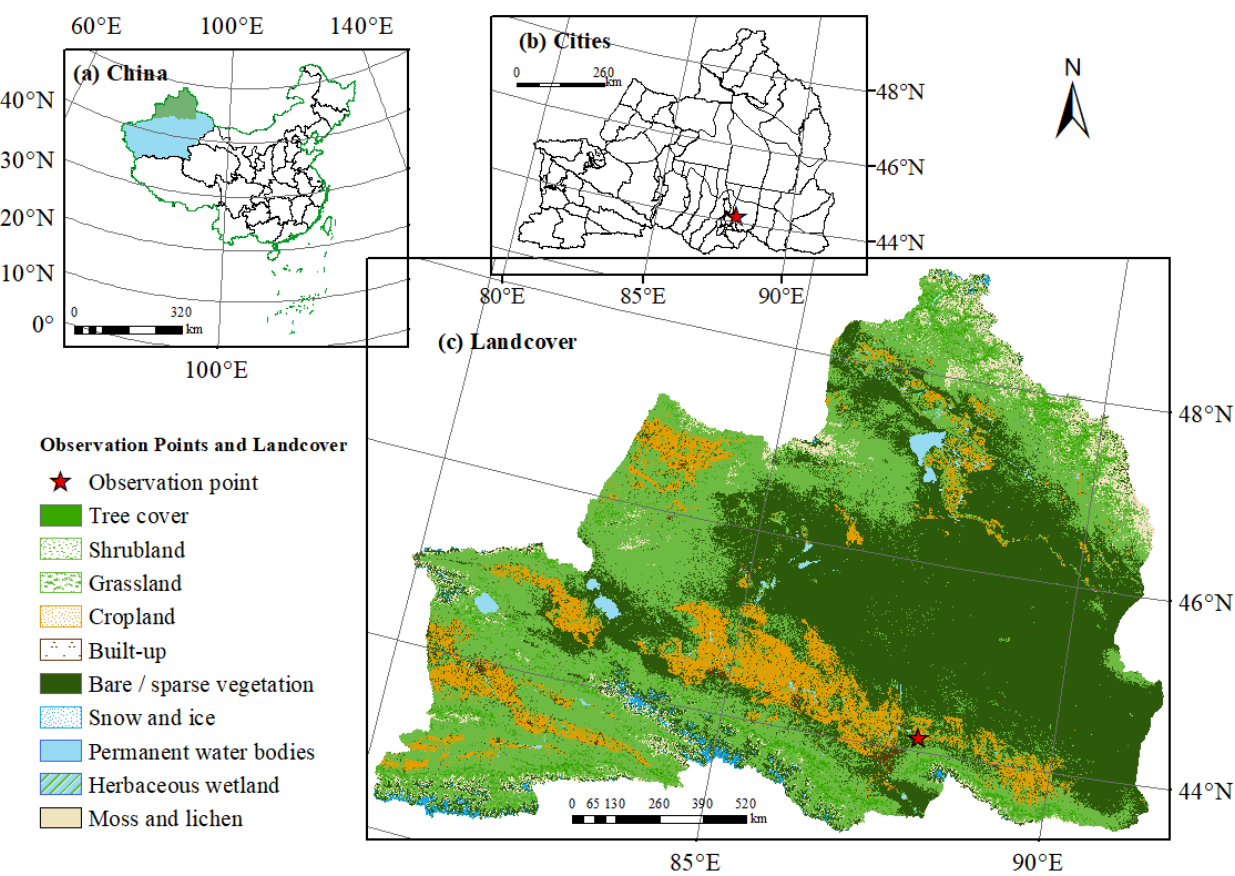
Figure 1. Map of China (a), City and County Map of Northern Xinjiang (b) and Landcover in Northern Xinjiang (ESA 10 m land cover data (c). Drawing review no.: GS (2020) no. 4619 .